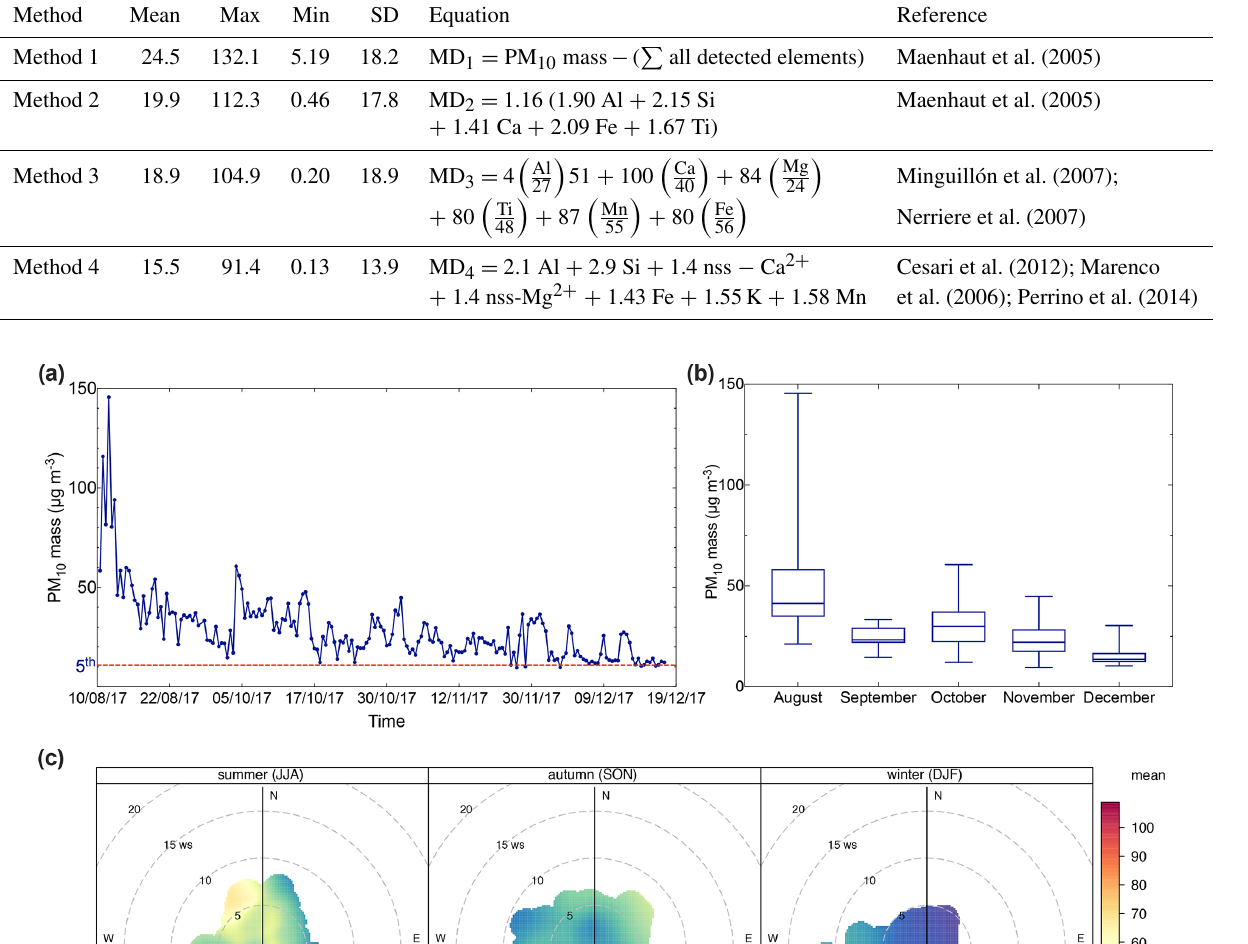
Table 2. Comparison of different methods for dust estimation. SD: standard deviation. Note that the concentrations of dust are given in micrograms per cubic meter (µgm − 3 ).